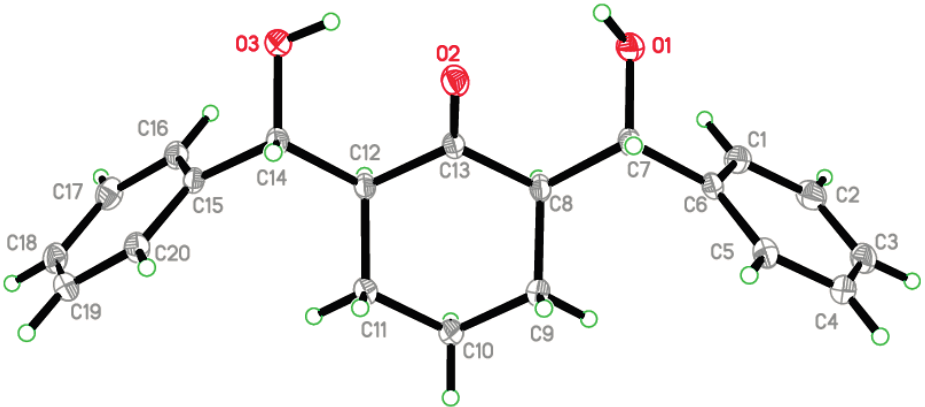
Figure 1. ORTEP diagram of the compound 1 . Displacement ellipsoids are plotted at the 50% probability